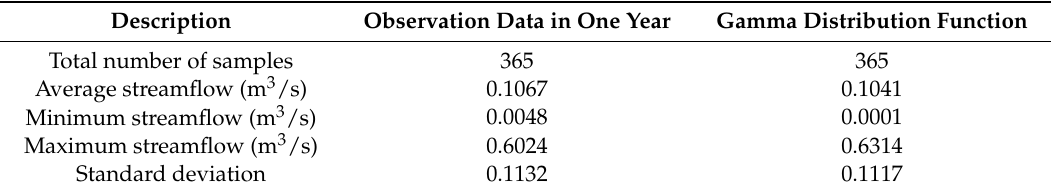
Table 4. Comparison of observation data and streamflow data form the Gamma distribution function.